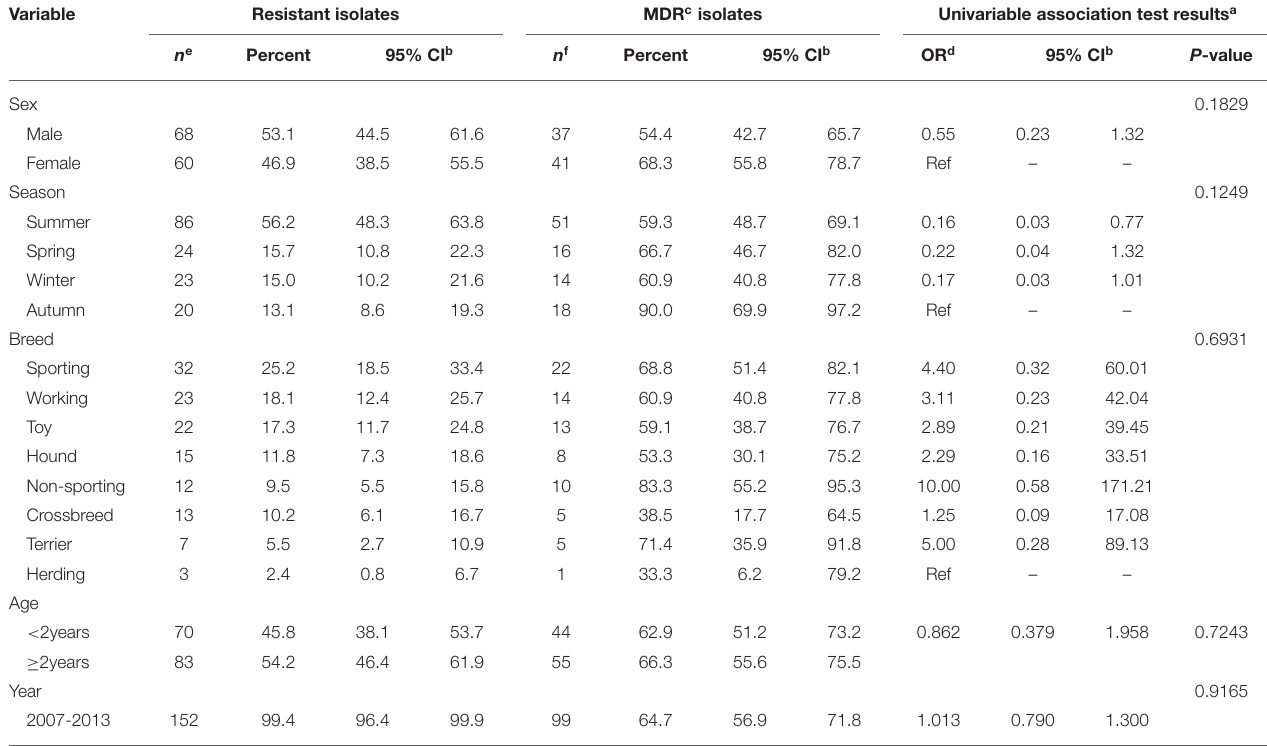
a Assessing association between multidrug resistance (MDR) and each of the variables listed in column 1. Note that none of the variables had significant association with log odds of MDR at 5% level of significance. However, sex and season had potentially significant associations with log odds of MDR at 20% significance level. b Confidence Interval. c Multidrug Resistance. d Odds Ratio. e Number of resistant isolates. f Number of multidrug resistant